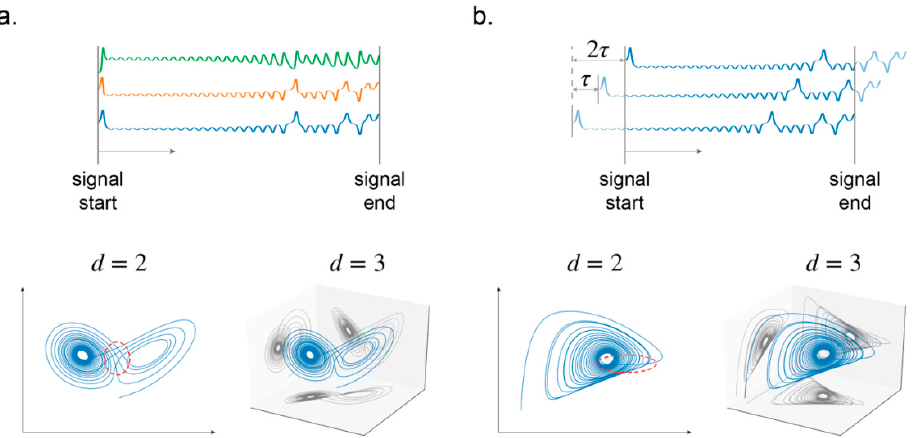
Figure 2. The effect of incrementing dimension on the reconstructed attractor. The two- and three-dimensional manifold of the Lorenz attractor. ( a ) Without time delay, where d = 2 can be seen as a projection of the three-dimensional signal on a 2D plane. ( b ) With time delay. The overlapping trajectory is marked on the two-dimensional plot.